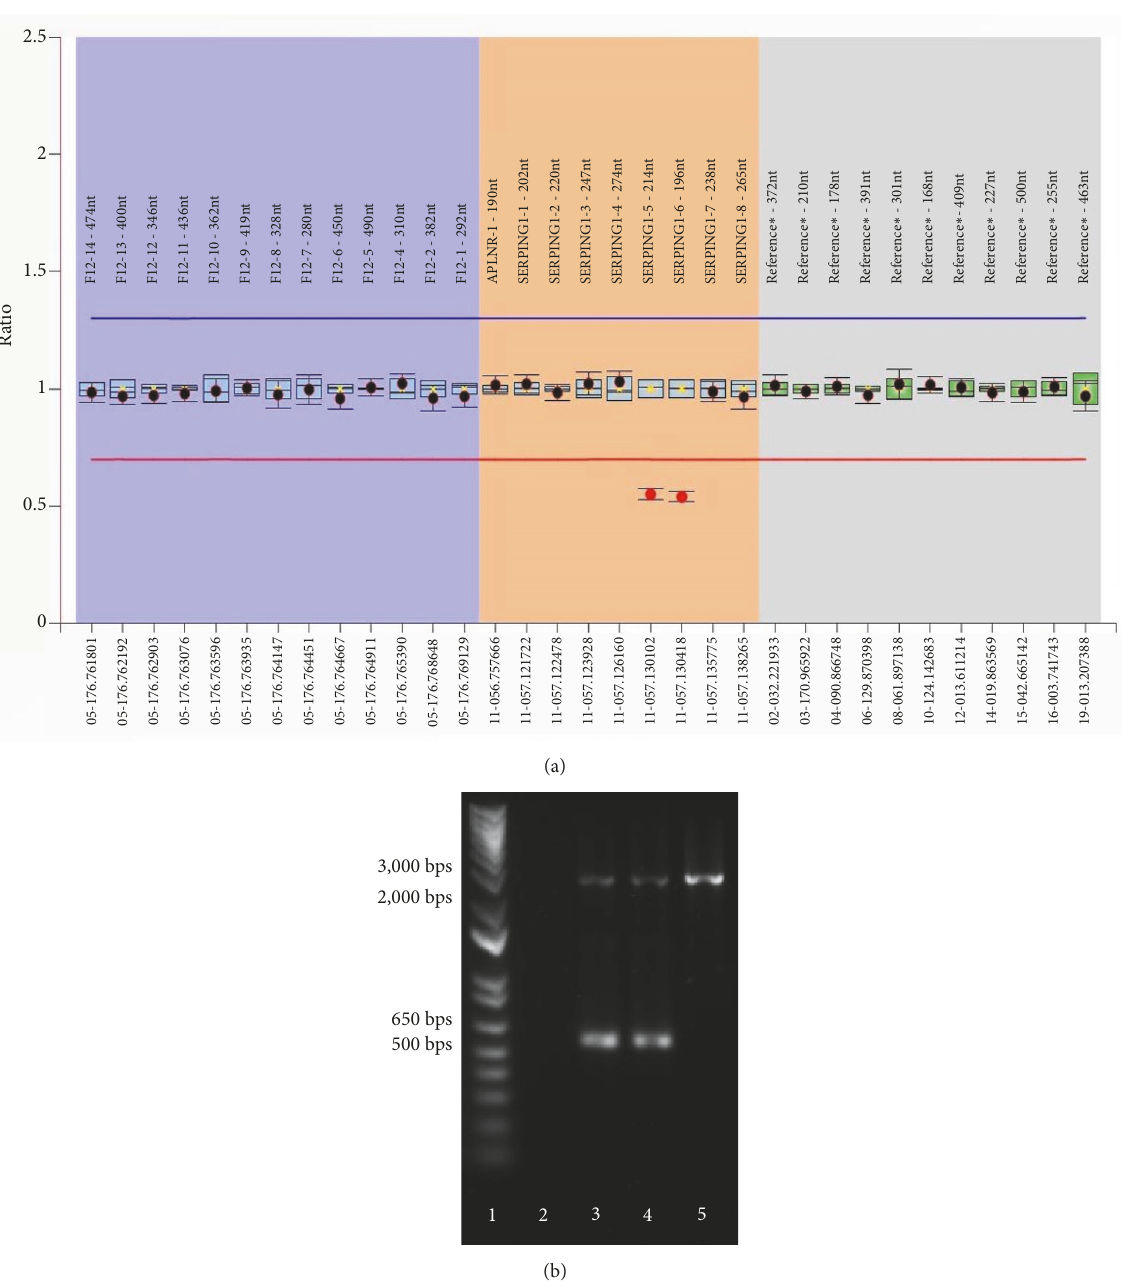
Figure 1: Heterozygous deletion of exons 5 and 6 in the patient’s genomic DNA was detected by the MLPA assay (a). The mother had an identical MLPA result (data not shown). The patient and her mother’s genomic DNA produced heterozygous PCR products, suggesting an approximately 2,000-bp deletion (b) (Lane 1: DNA ladder; Lane 2: negative control; Lane 3: patient; Lane 4: patient’s mother; and Lane 5: wild-type